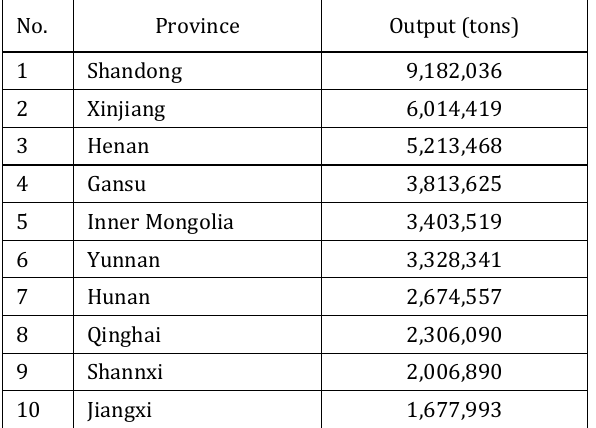
Table 2. Top ten nonferrous metal producing provinces in China in 2015 (Source: Cnal,